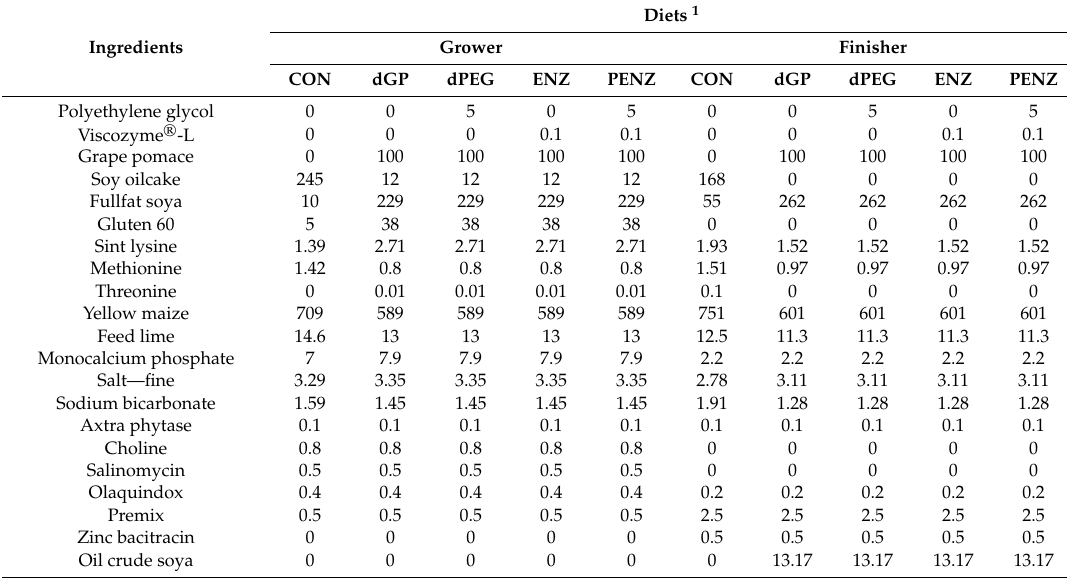
1 Diets: CON = commercial chicken diet without red grape pomace; dGP = commercial chicken diet containing 100 g / kg untreated red grape pomace; dPEG = commercial chicken diet containing 100 g / kg red grape pomace pre-treated with polyethylene glycol (50 g / kg); ENZ = commercial chicken diet containing 100 g / kg red grape pomace pre-treated with Viscozyme ® -L (1 g / kg); PENZ = commercial chicken diet containing 100 g / kg red grape